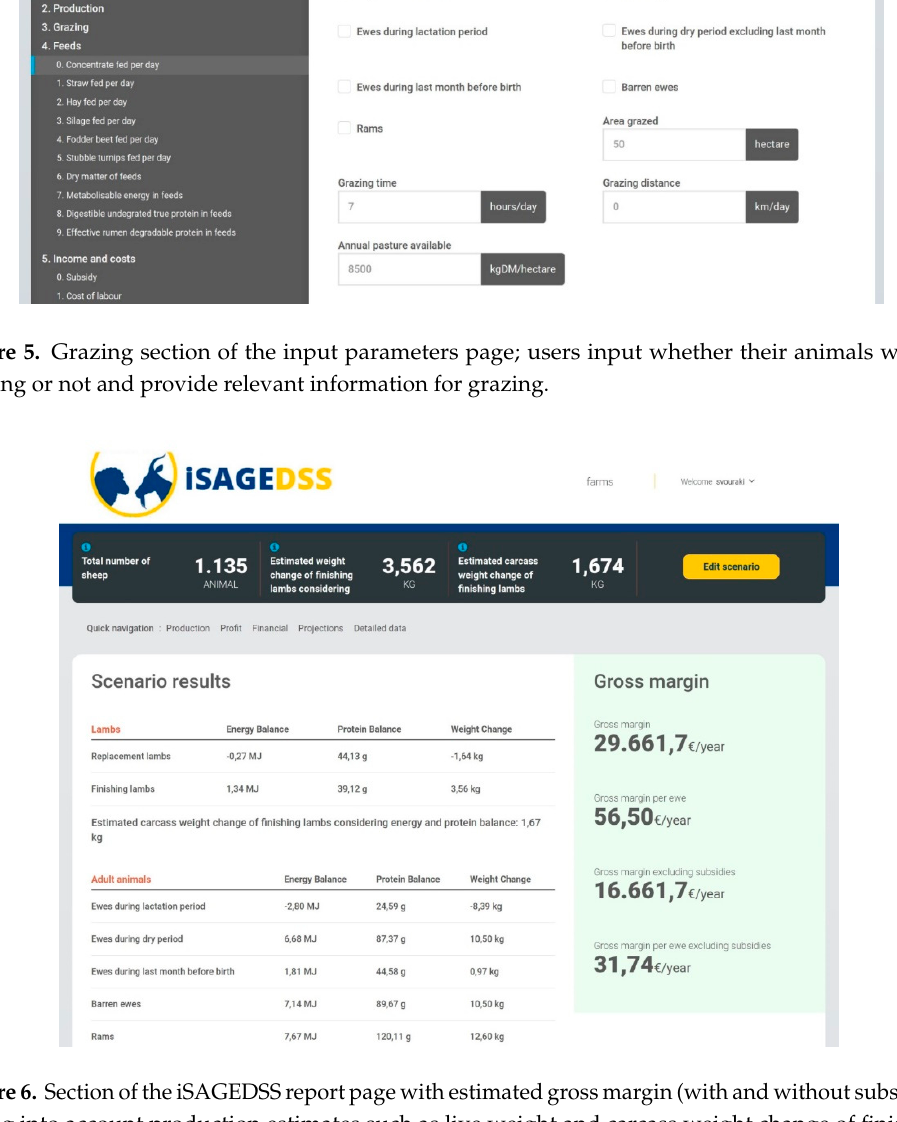
Figure 5. Grazing section of the input parameters page; users input whether their animals will be grazing or not and provide relevant information for grazing.